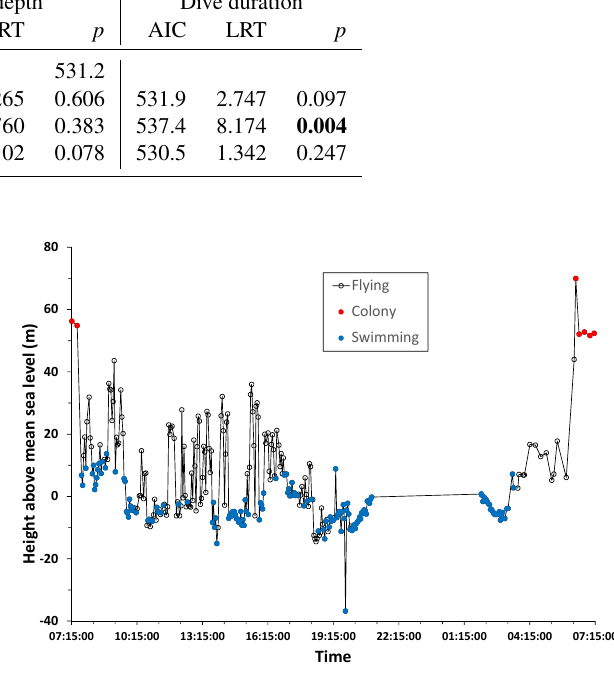
Figure 7. Altitude measurements for a northern gannet tracked in summer 2015 on Heligoland. Altitude measurements are related to activities “in colony” (before and after the 22.7h foraging trip), swimming, and flying. For details, see text. Please note that this device was switched off during the core darkness hours to save en- ergy, and because birds are known to either stay at the nest site or rest at the sea surface during this period (as shown